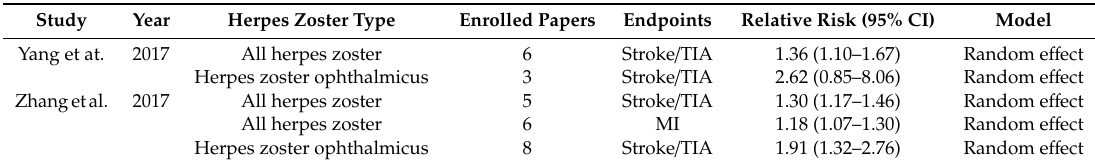
Table 4. Summary of meta-analysis results of herpes zoster and herpes zoster ophthalmicus with stroke or myocardial